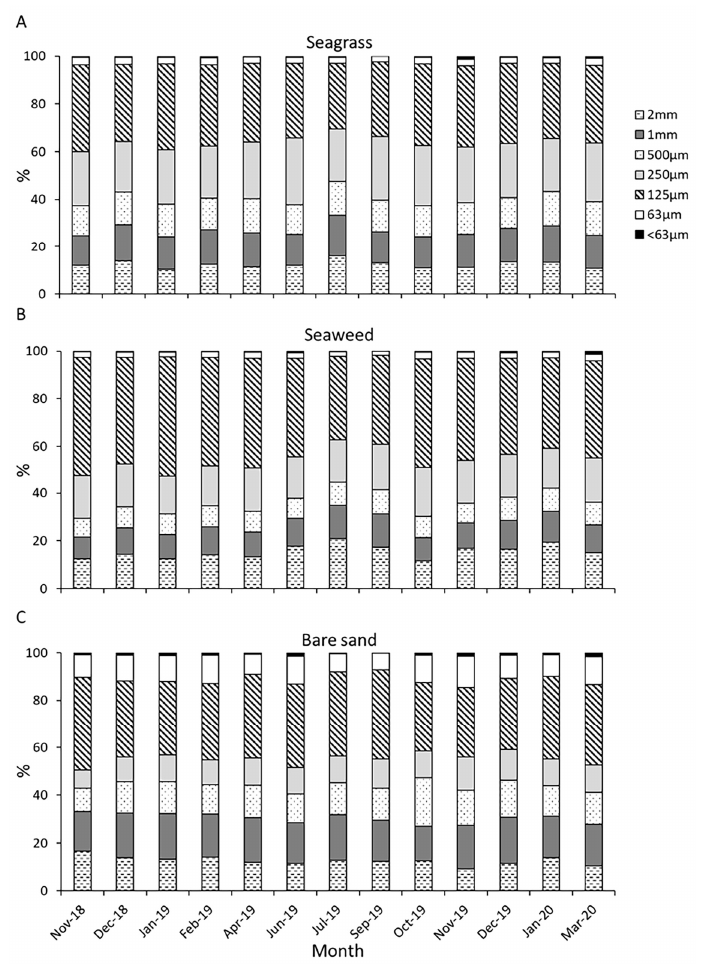
Figure 4. Distribution of sediment size (mean ± SE) in ( A ) seagrass; ( B ) seaweed; and ( C ) bare sand habitats from November 2018 to March 2020.